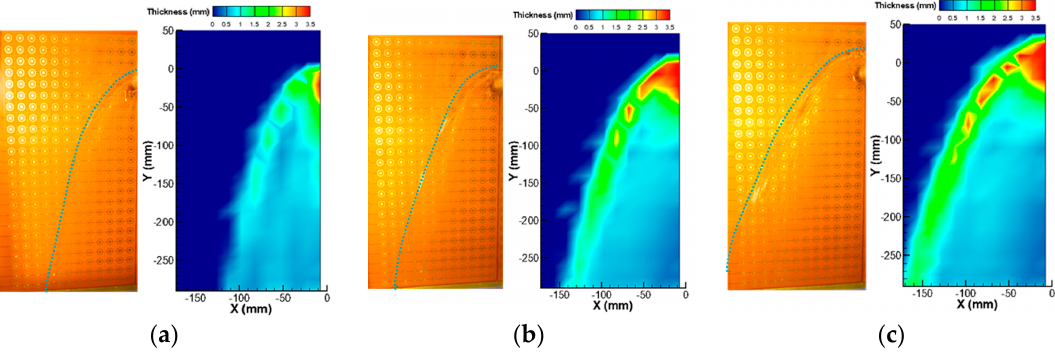
Figure 17. Local liquid film thickness of different liquid inlet velocities: ( a ) V in = 0.48 m/s; ( b ) V in = 0.68 m/s; and ( c ) V in = 0.87 m/s.